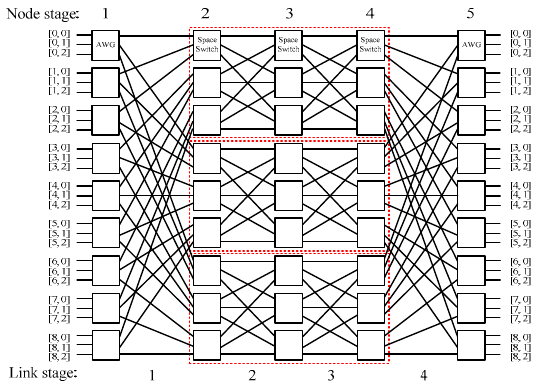
Figure 4. A general multi-stage 27 × 27 ASA switch. Each middle 9 × 9 space switch in Figure 3 is decomposed into a C(3, 3, 3) network (i.e., a 3 2 × 3 2 Benes network) within a red box.